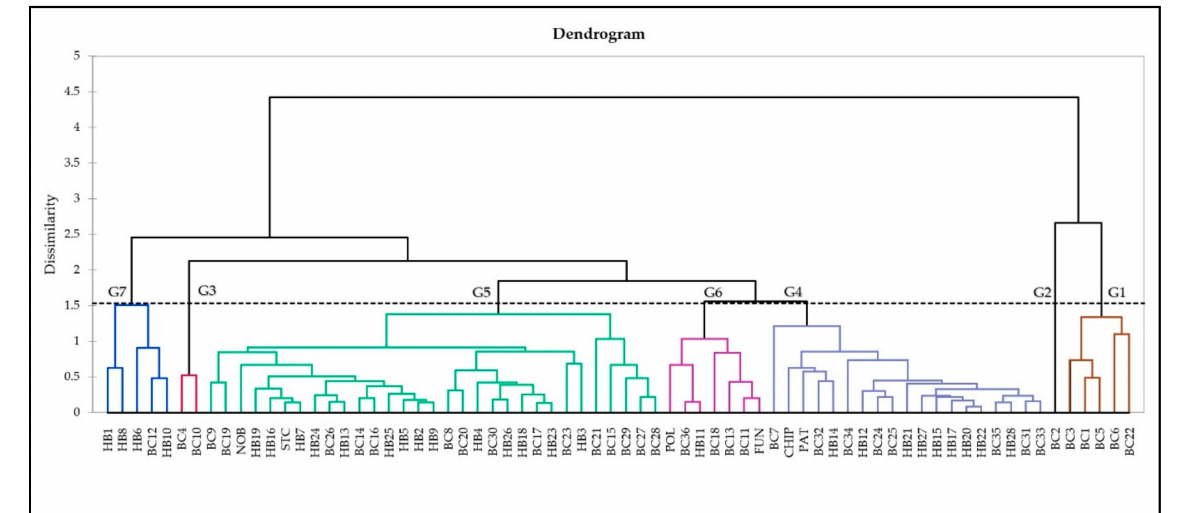
Figure 2. AHC dendrogram by the unweighted pair-group average (UPGMA) method, based on a Euclidean dissimilarity distance matrix of antioxidant activity, phenolic and flavonoid content data for 70 genotypes.